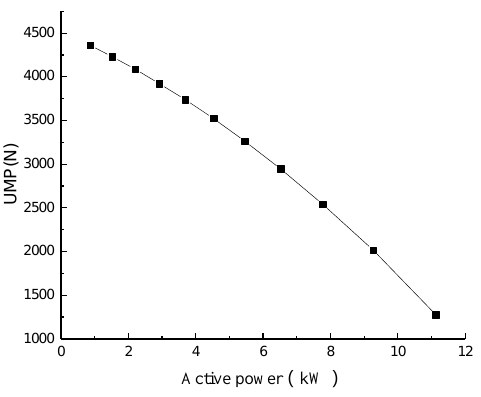
16 of 19 Table 7. Operation data of A1552 model machine field winding on taps 2–4 short circuit. PFA: power factor angle. PFA (°)